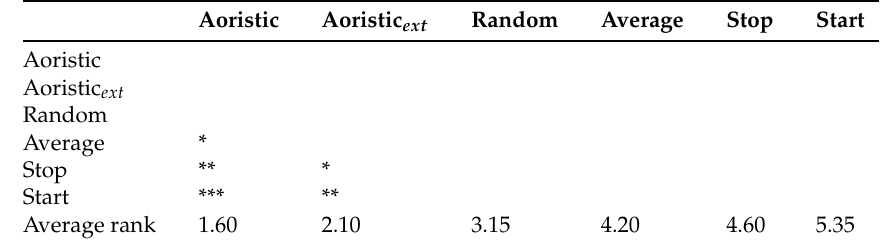
Table 11. Nemenyi significance test results from pair-wise comparisons between temporal analysis methods in the temporal resolutions of weekday with reduced numbers of crimes available during analysis.